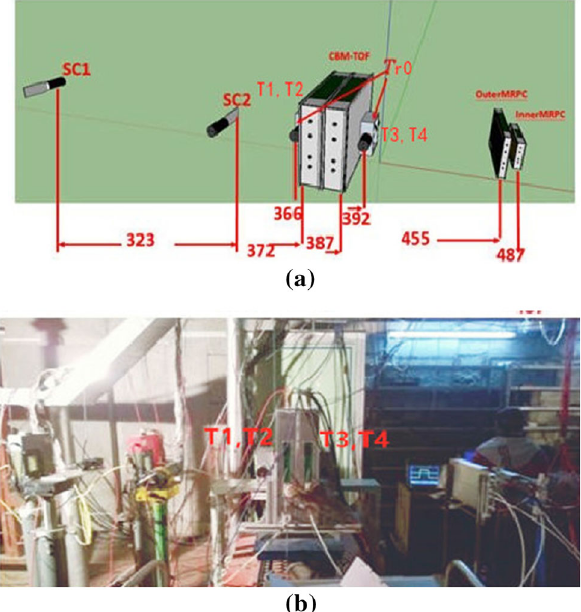
Fig. 7 Sketch(top a )andphotograph(bottom b )ofexperimentalsetup attheE3lineofBEPCII.Thenumbersintheupperplotmarktheposition (in cm) along the beam line